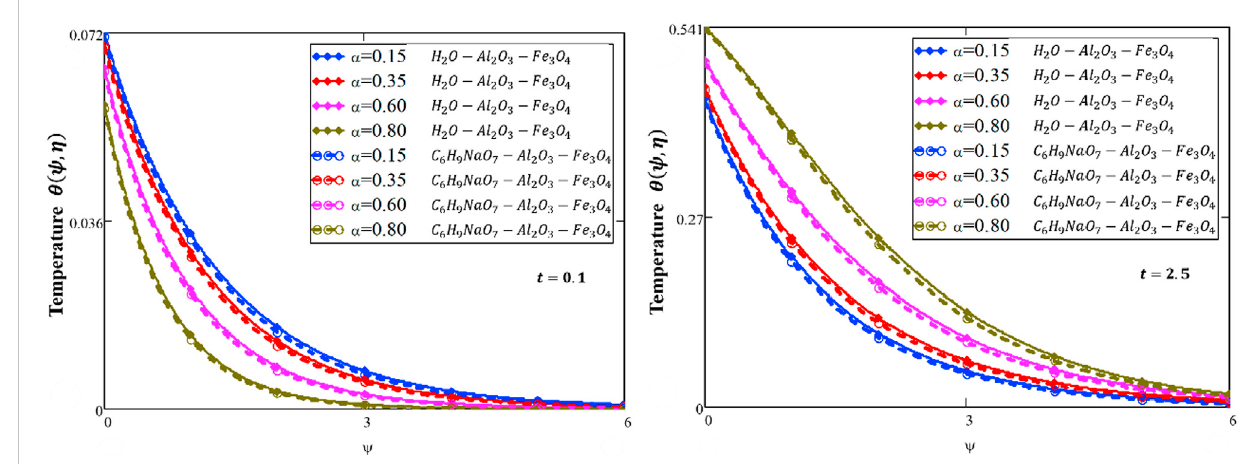
FIGURE 2 Simulation to explain the temperature for changing α when Pr (cid:3) 3and ϕ 1 (cid:3) ϕ 2 (cid:3) 0 . 4.